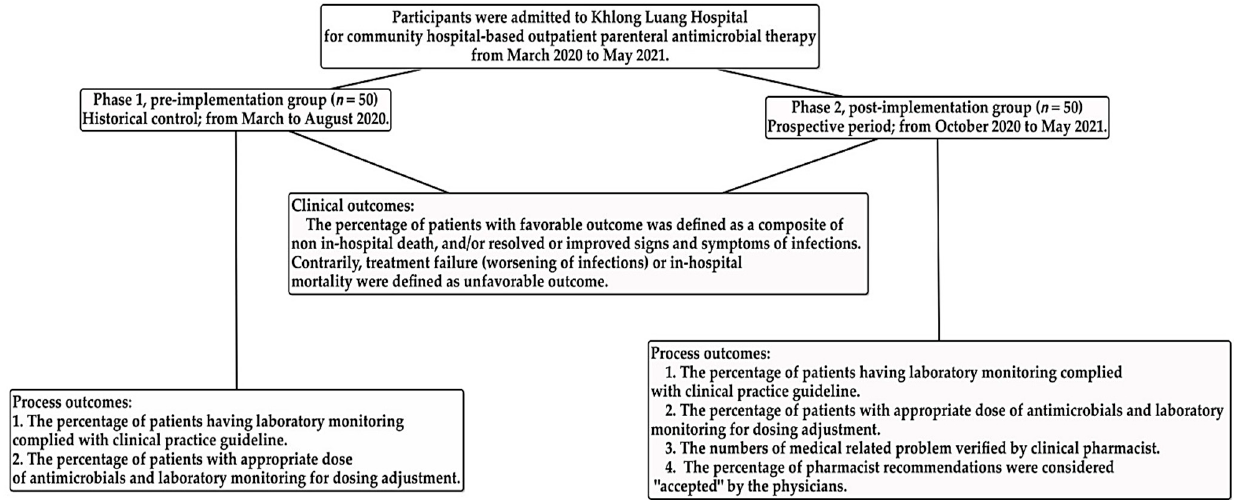
Figure 1. Diagram of study participation of analysis process and clinical outcomes.